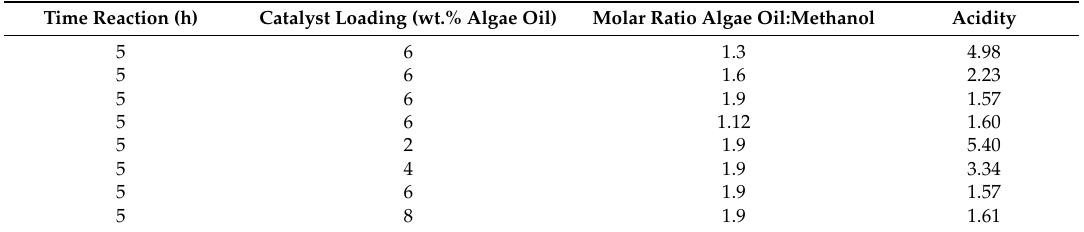
Table 4. Parameters optimization for esterification reaction over SO 42 − /TiO 2 -ZrO 2